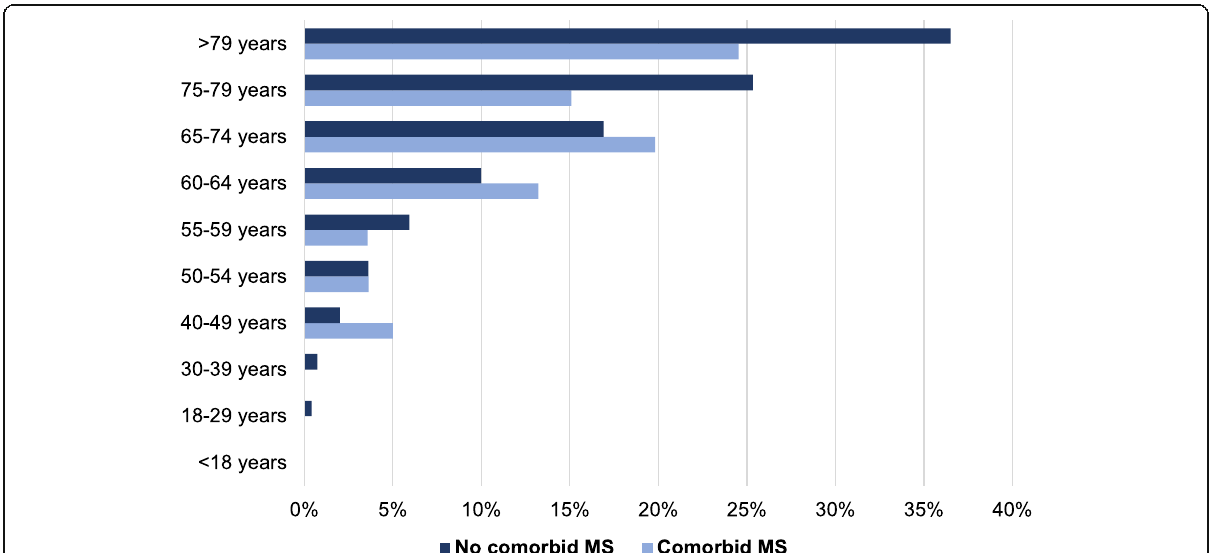
Fig. 4 In-hospital mortality rates of COVID-19 patients stratified by age and the presence of comorbid MS. P -Value > 0.05 for all age-group comparisons among patients with and without comorbid